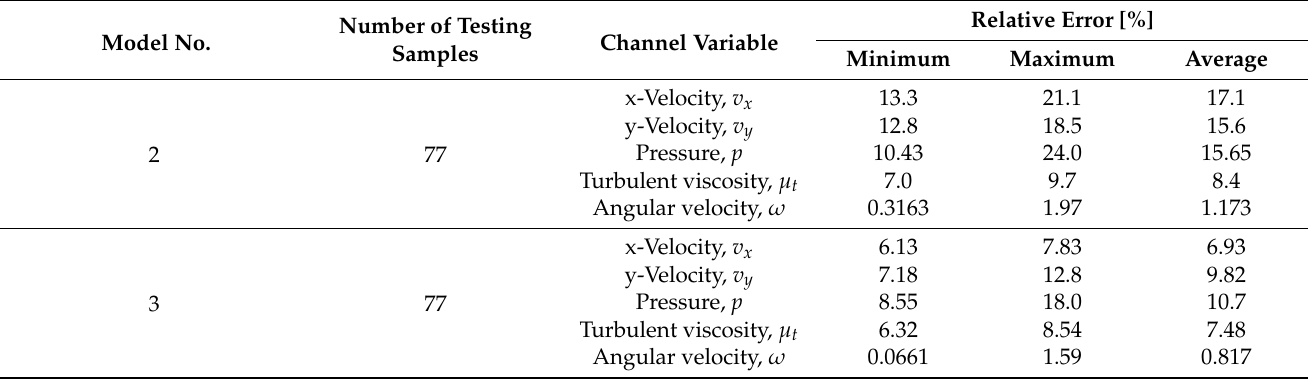
Table 10. Relative errors produced by Model 2 and Model 3, for the combined testing cases of v ∞ = 2.0 and 2.5